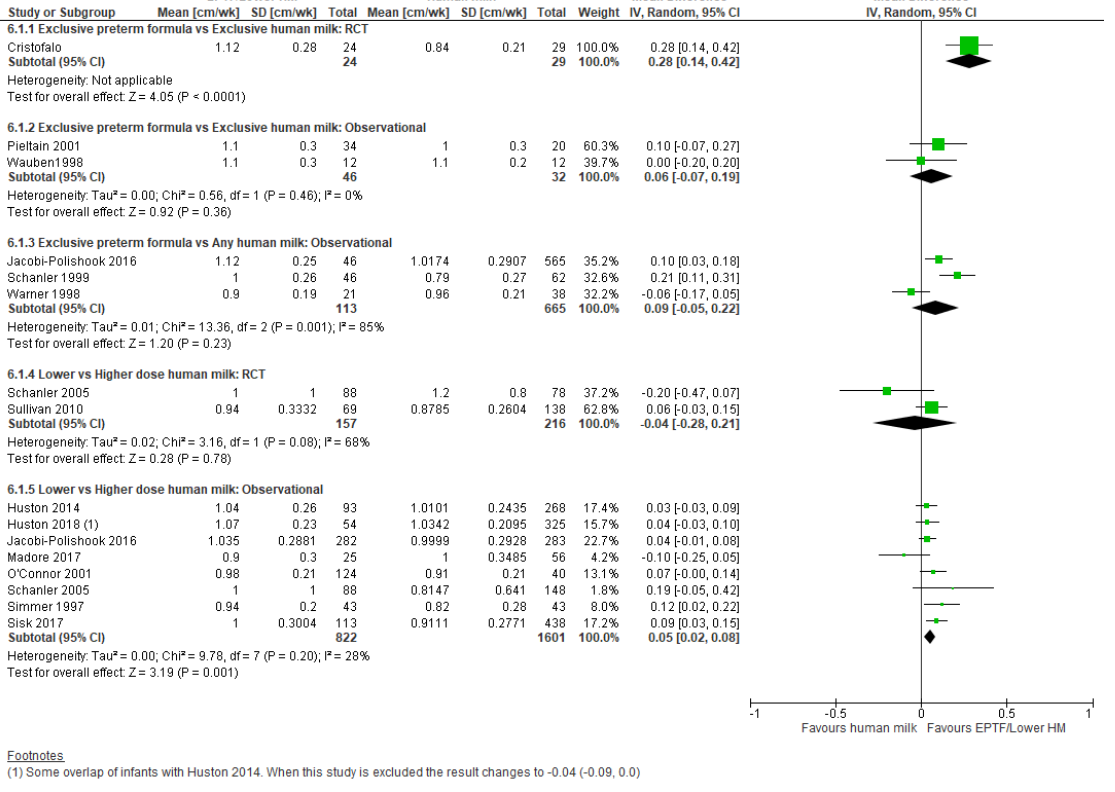
Figure 6. Forest plot of mean difference in change in length gain (cm/wk) and human milk intake.